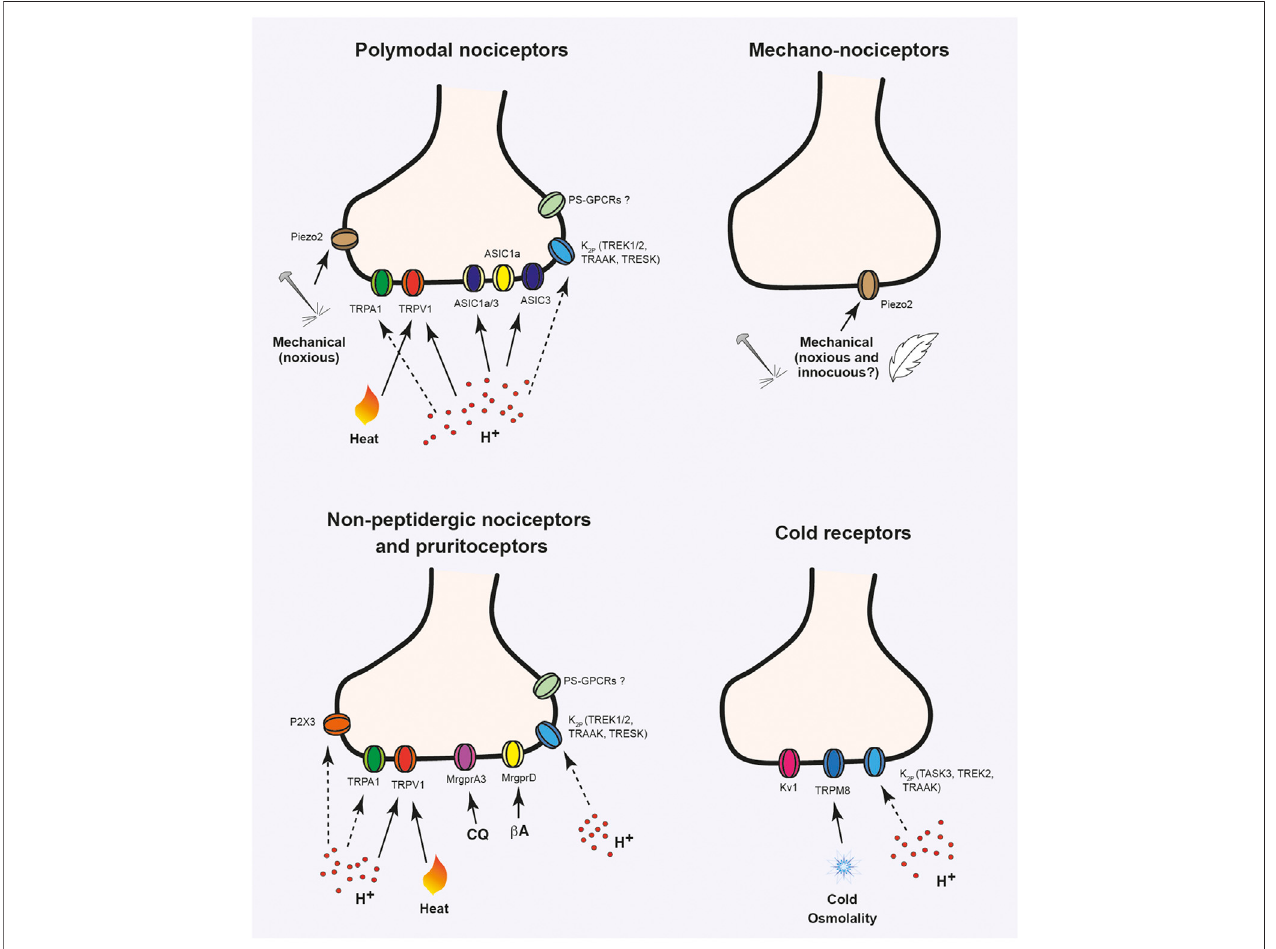
FIGURE 2 | Ion channels activated or modulated by acidic stimuli in ocular sensory neurons. Ion channels expressed in trigeminal sensory neuron terminals innervating the cornea, sclera and conjunctiva. Different types of nociceptive fi bers are shown: mechano-nociceptors that respond to high threshold mechanical stimulation; polymodal nociceptors, which can be activated by chemical, mechanical and thermal (noxious heat or cold) stimulation; cold thermoreceptors that express TRPM8 and respond to non-noxious cold stimuli and non-peptidergic sensory neurons, involved in nociception and itch sensitivity. Solid lines indicate direct activation by stimulus. Dashed lines indicate modulation of ion channel activity by protons. CQ, chloroquine; β A, β -alanine.